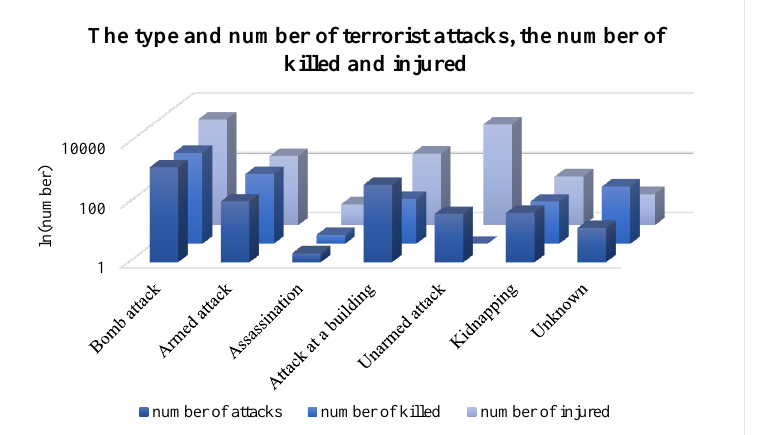
Figure 4. The type and amount of terrorist attacks, the amount of killed and injured in the world over the period 2000 – 2017 [20].